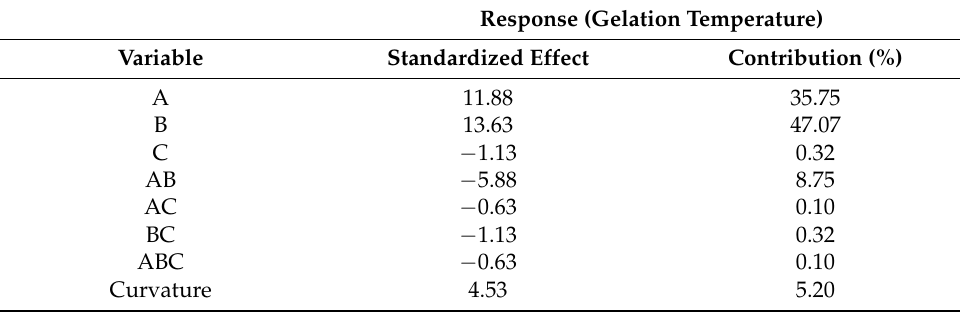
Table 3. Effects of each single variable and its interactions in variable